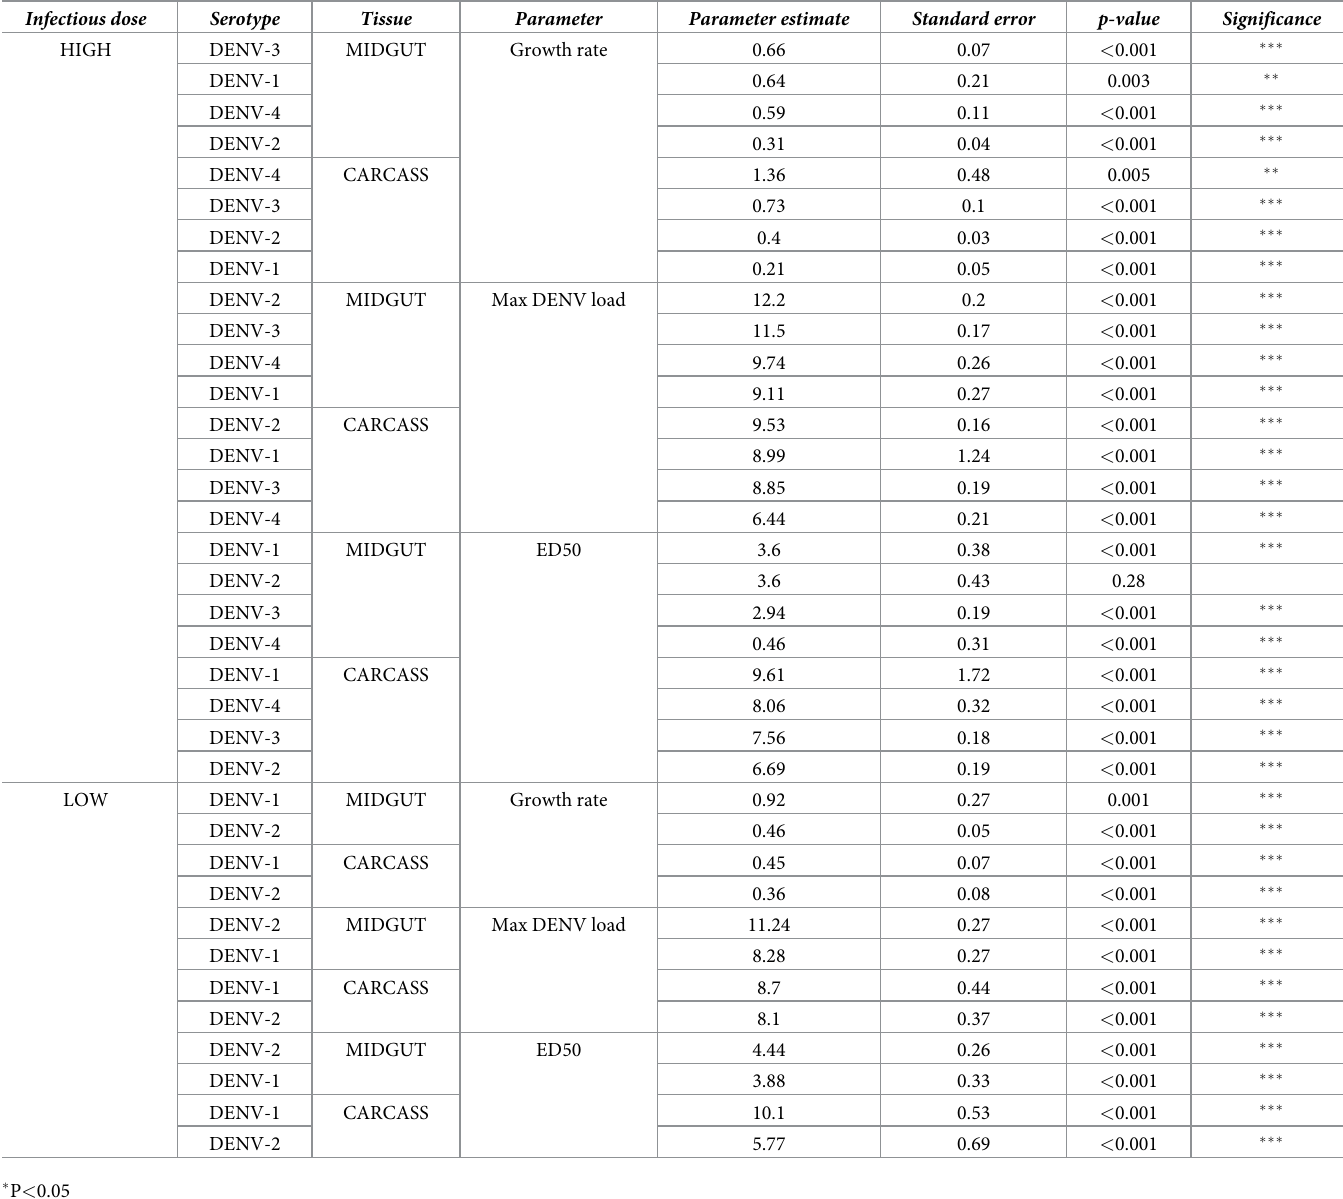
Table 2. DRC parameters for successful infections by tissue, infectious dose and strain. Infectious dose